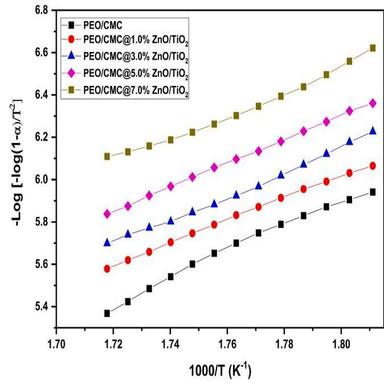
The plots of -log versus 1000/T (K− 1 ) plot for prapared samples.